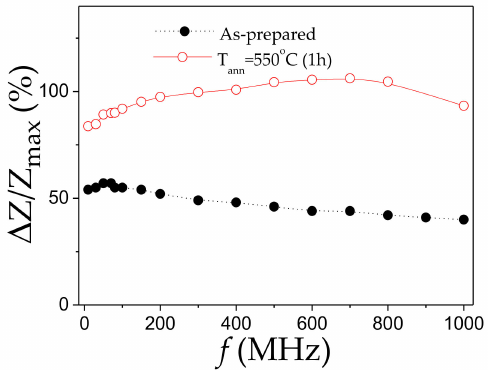
Figure 14. Frequency dependence of maximum GMI ratio of as-prepared and annealed at 550 ◦ C (1 h) Fe 71.7 B 13.4 Si 11 Nb 3 Ni 0.9